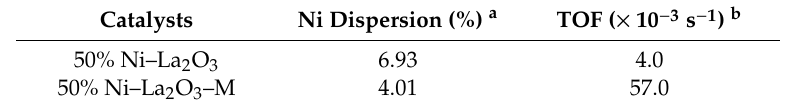
Table 3. Ni dispersion and turnover frequency (TOF) calculated from H 2 -TPD